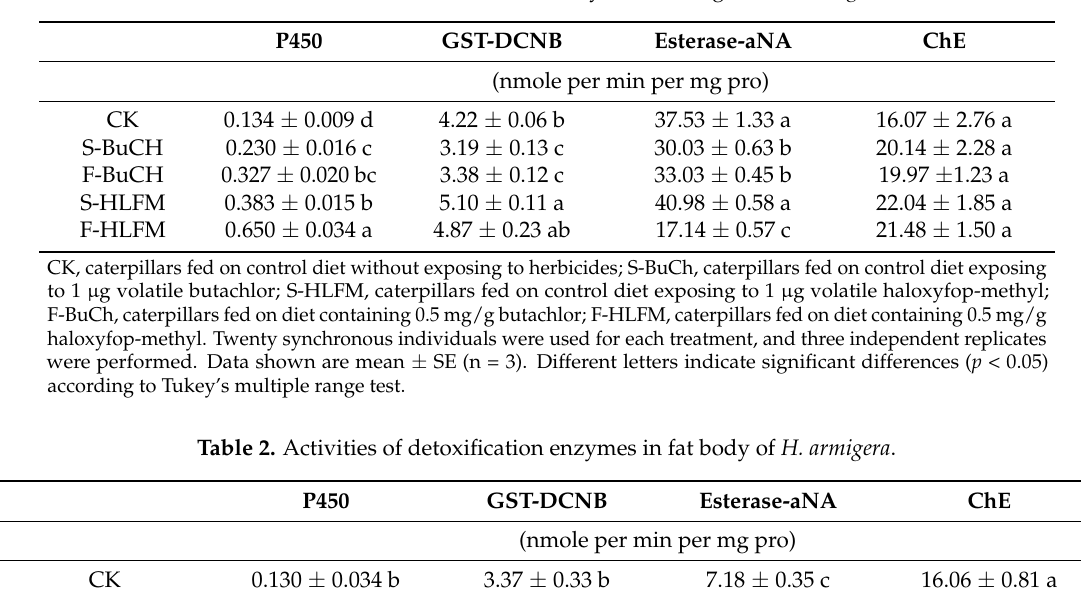
Table 1. Activities of detoxification enzymes in midgut of H. armigera .